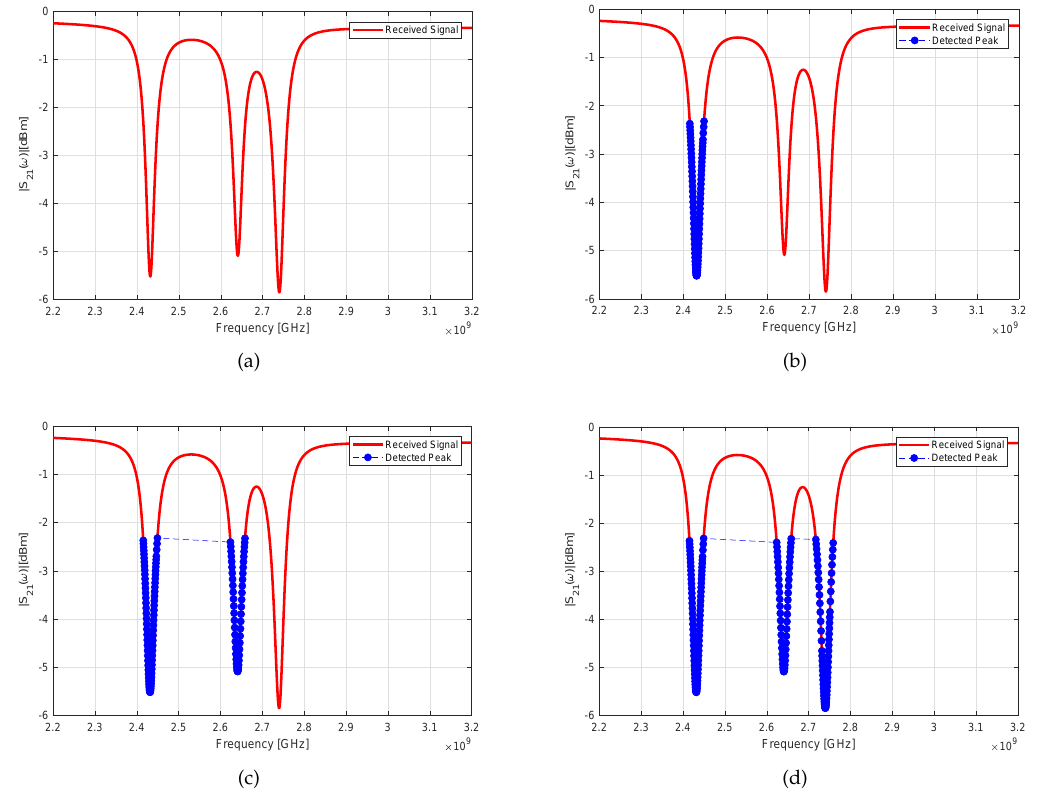
Figure 5. Peak detected for the tag configuration of 10110, ( a ) original detected signal, peaks between the frequency range of ( b ) 2.4–2.5 GHz, ( c ) 2.6–2.7 GHz, ( d ) 3.1–3.2